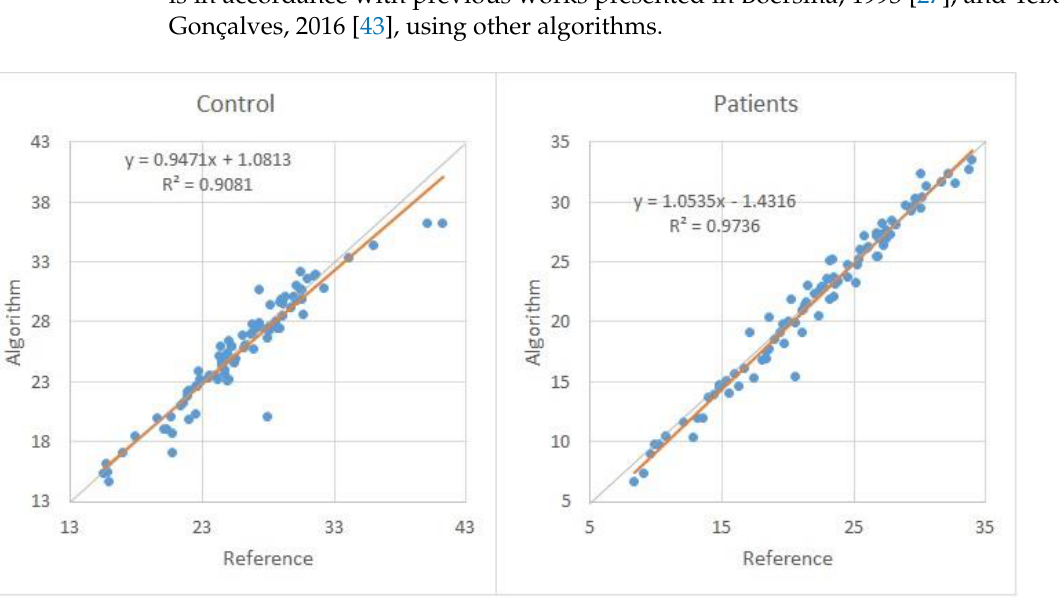
Figure 5. Comparison of Autocorrelation values for the 90 control measurements (left-hand side) and 90 patient measurements (right-hand side). Figure 5 shows that the results obtained by the algorithm and the reference for the Autocorrelation are almost identical, with a large part of the values overlaid. Thus, for the Autocorrelation, the window can be a Hanning, Hamming, or Blackman window with a length of six glottal cycles.